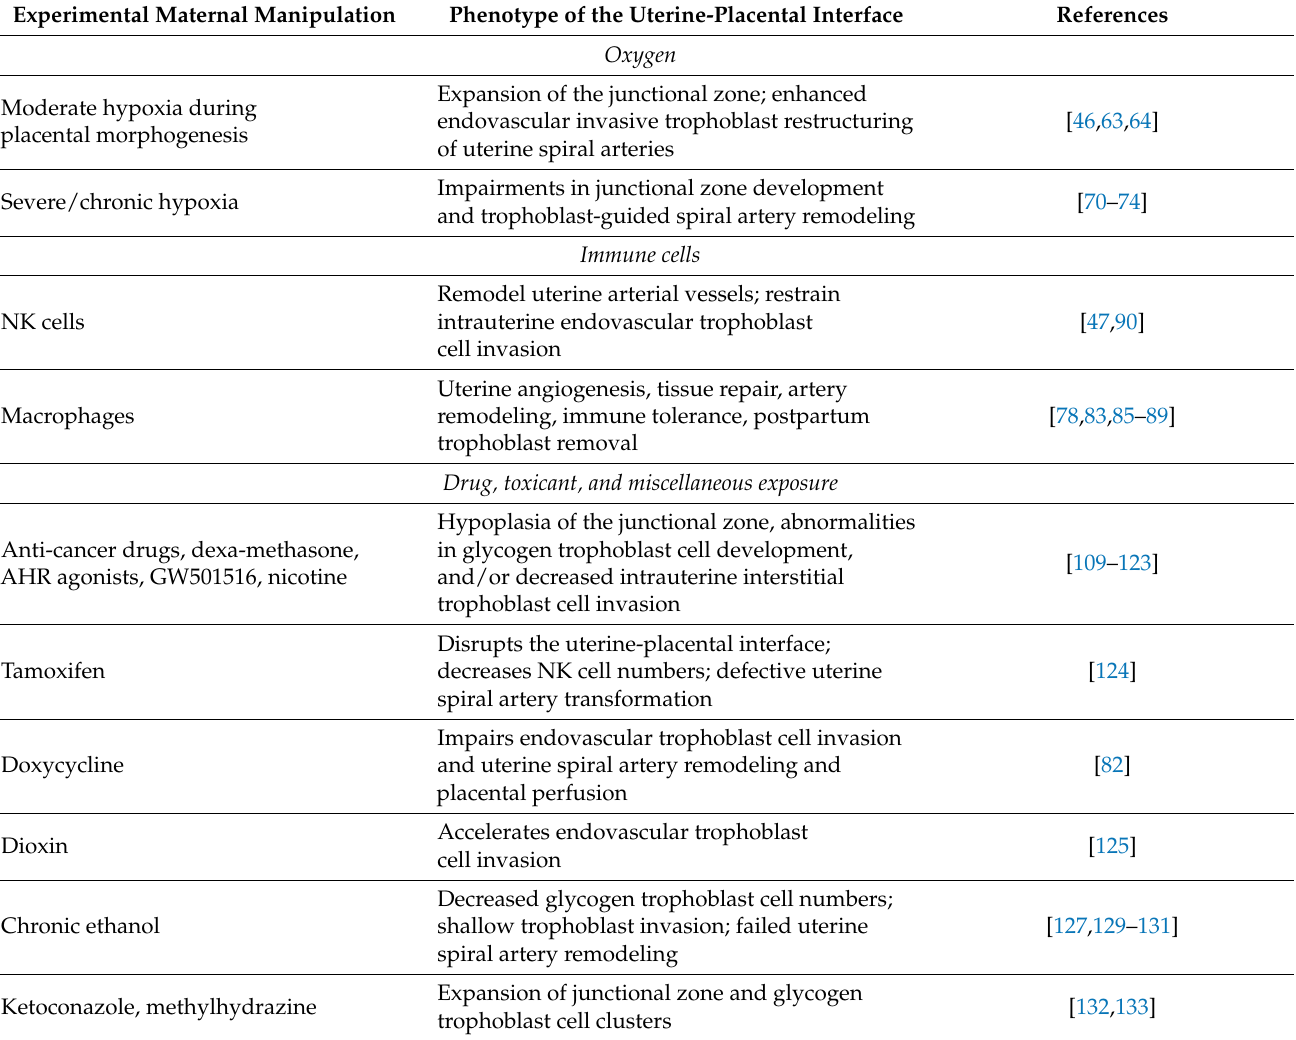
Table 1. Experimental manipulations impacting the rat uterine-placental